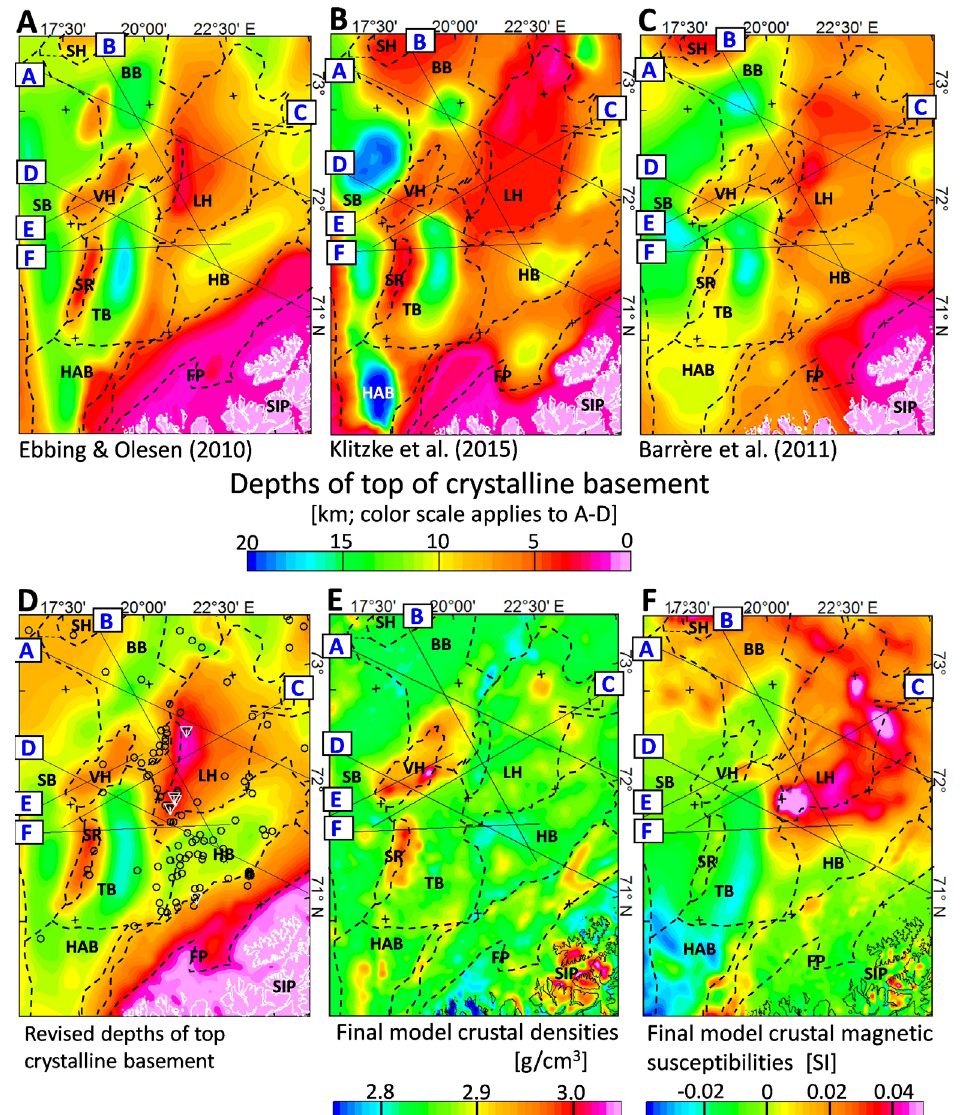
Figure 7. (A), (B) & (C) Digitised depths of the top crystalline basement from publications. (D) Revised map of depth of the top crystalline basement with locations of wells (factpages.npd.no, visited 11.01.2022), penetrating the crystalline basement (white triangles), and other wells with termination depth in the sediments (black circles). (E) Final model grid of (crystalline) crustal densities. (F) Final model grid of (crystalline) crustal magnetic susceptibilities. Boundaries of structural elements (black dashed, details in Fig. 1, abbreviations in Fig. 2), seismic profiles (black lines, details in Fig.